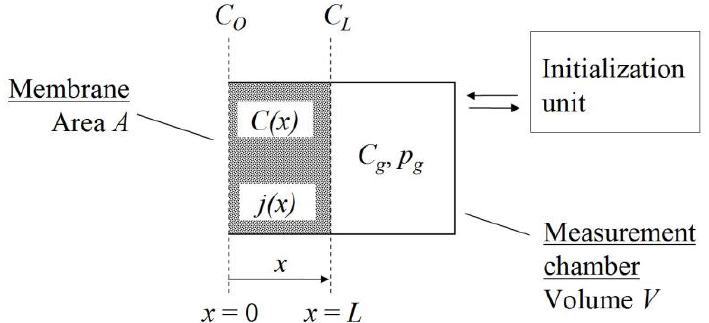
Figure 1. The cell of a membrane-based gas sensor: C ( x ), C j ( x ) is the flux density of a gas within the membrane; C pressure within the measurement chamber. Initial gas concentrations for the measurement chamber are provided using an initialization